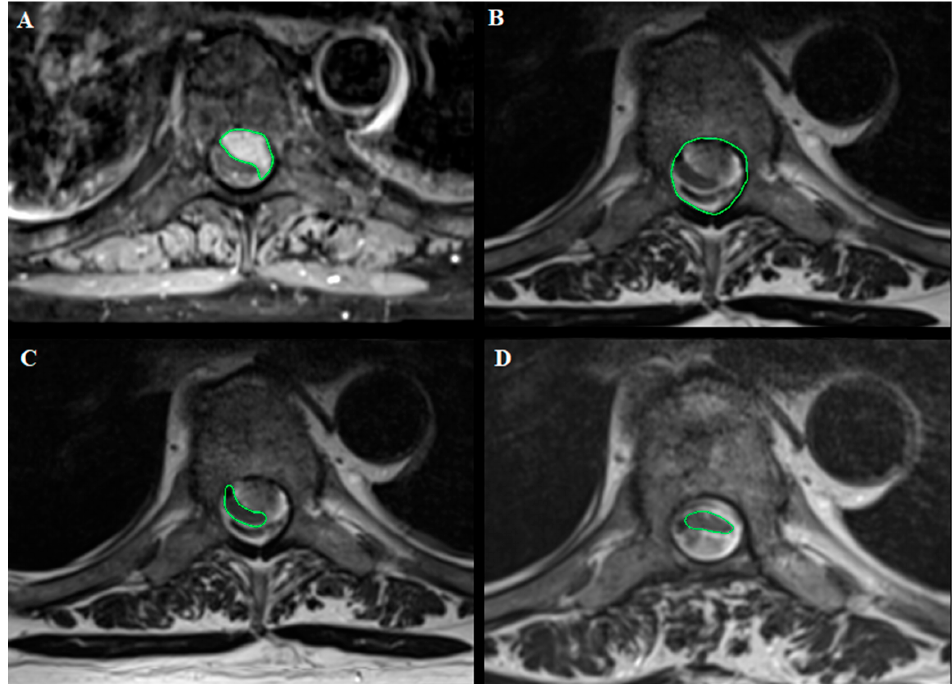
Figure 2. Dorsal Th7 WHO grade I meningioma with anterior dural attachment: ( A ) Tumor area (111 mm 2 ) measured at maximal compression on axial T1-weighted images after contrast administration; ( B ) spinal canal area (210 mm 2 ) measured at maximal compression on axial T2-weighted images; ( C ) spinal cord area (39 mm 2 ) measured at maximal compression on axial T2-weighted images; ( D ) postoperative spinal cord area (42 mm 2 ) measured at the level of preoperative maximal compression on axial T2-weighted images. The measurements were made using OsiriX Lite ®